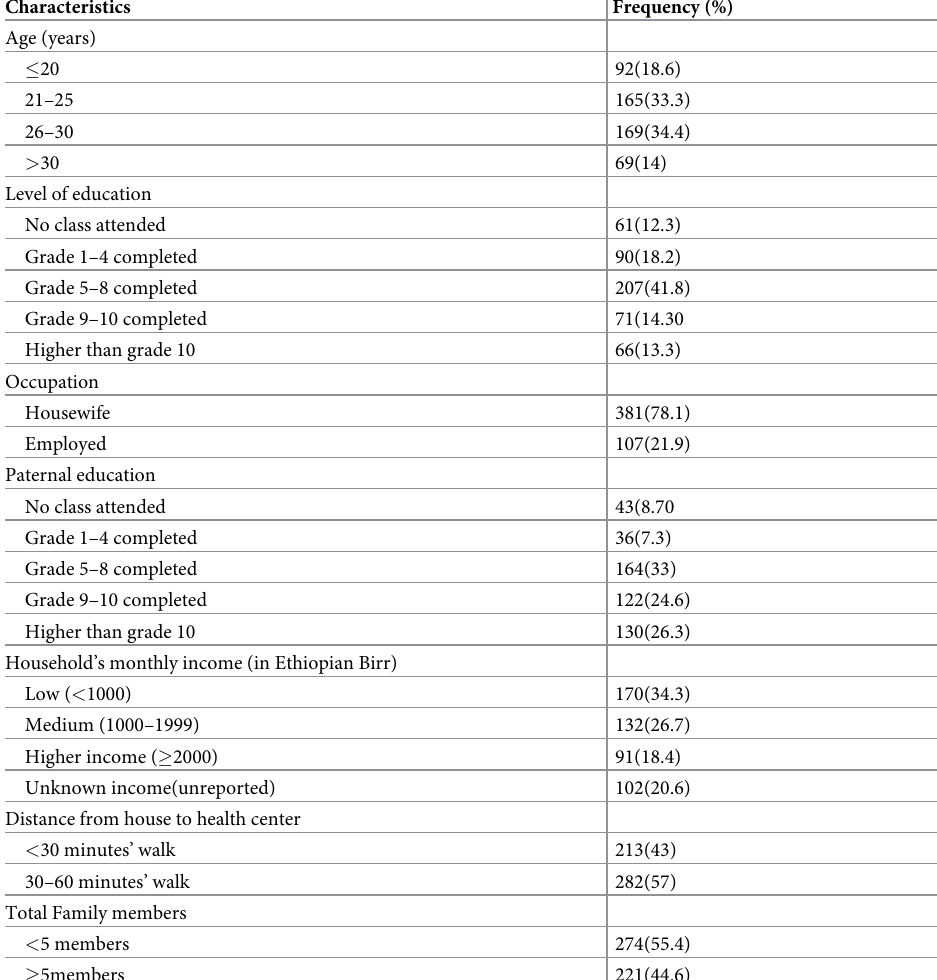
Table 1. Socio-demographic characteristics of women with infants(0-12months) at three districts in Sidama Administration, 2018.